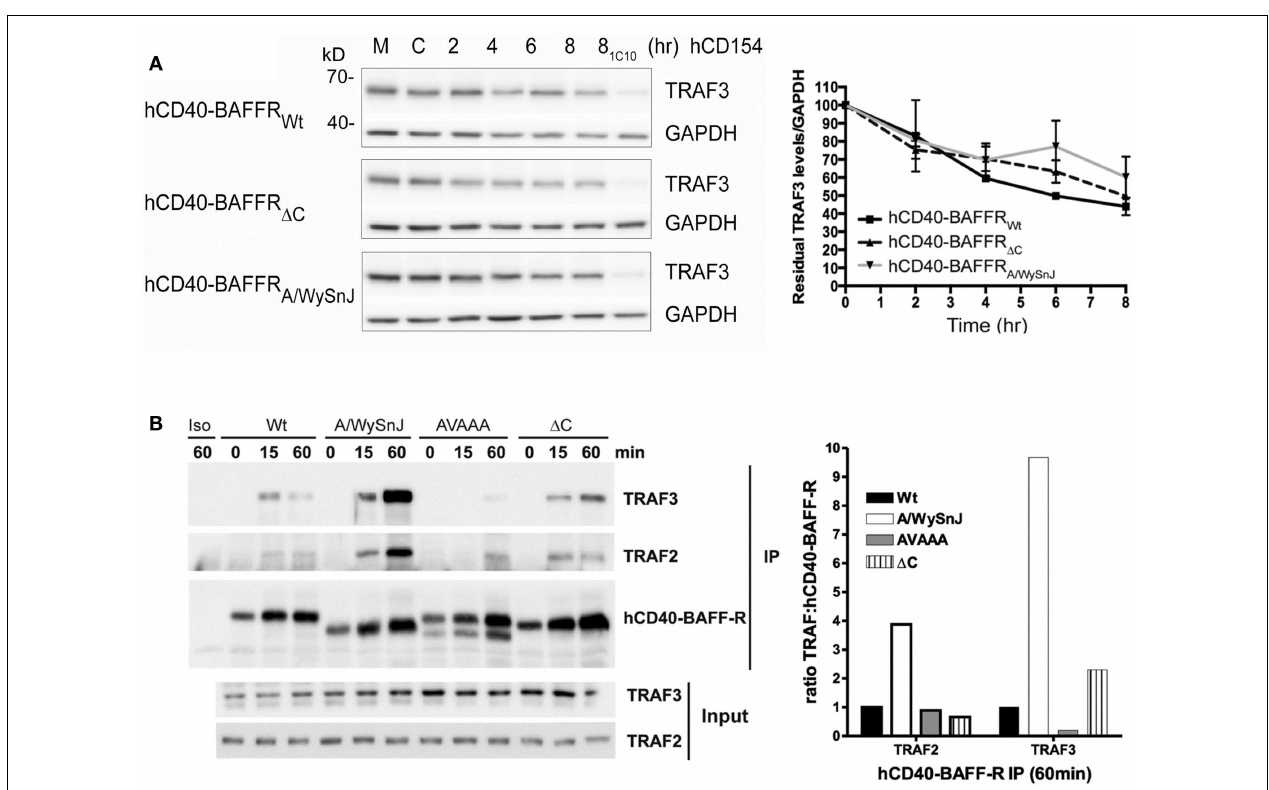
mean ± SEM of data combined from three independent experiments. (B) CH12.LX B cells subclones as in Figure 6D and CH12.LX B cells that expressed hCD40-BAFFR with disruptedTRAF3 binding sites (AVAAA) were stimulated with anti-hCD40 mAb or isotype control (Iso) coated beads and immunoprecipitated as mentioned in Section “Materials and Methods.”The bead bound protein complexes were separated on SDS-PAGE and immunoblotted forTRAF2 andTRAF3. Representative blots from three independent experiments were shown. Bar graph represents relative levels ofTRAF2 andTRAF3 normalized to hCD40-BAFFR chimera